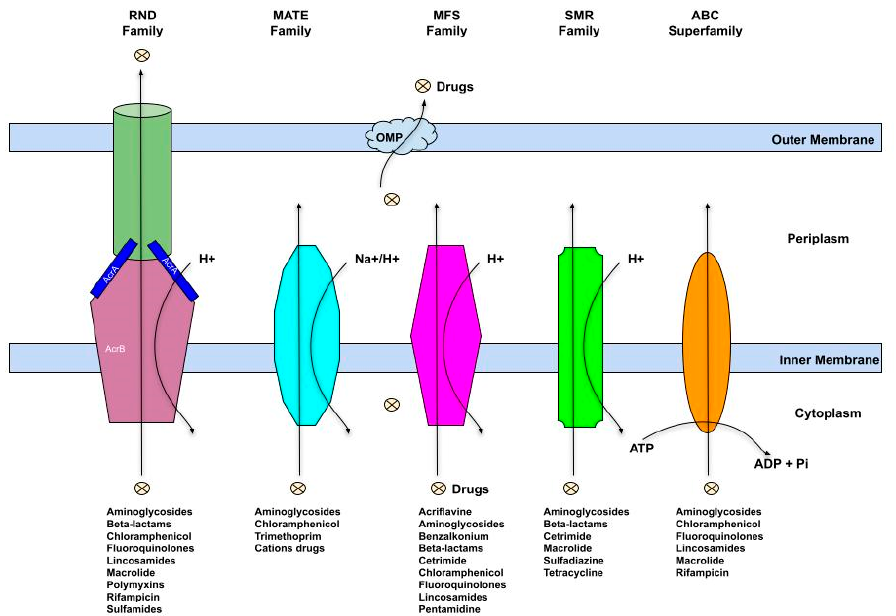
Figure 5. Different classes of efflux systems.